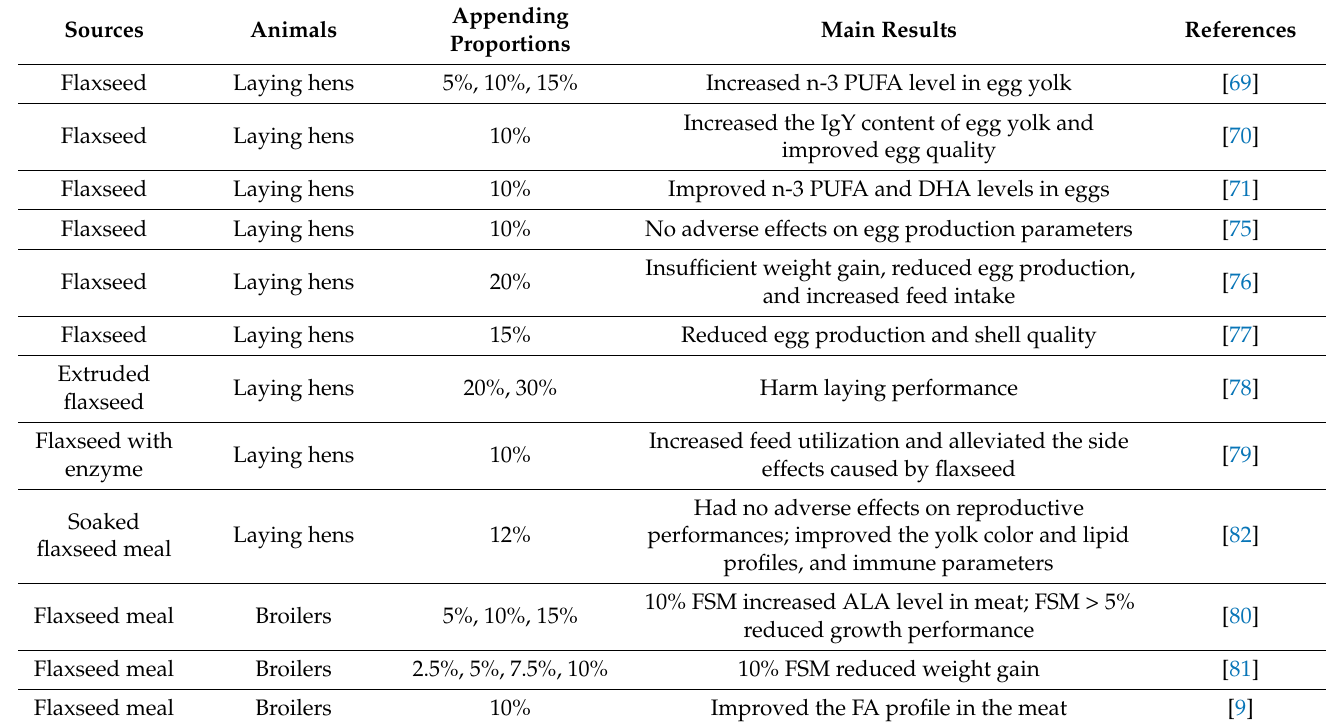
Table 6. Application of flaxseed and flaxseed meal in